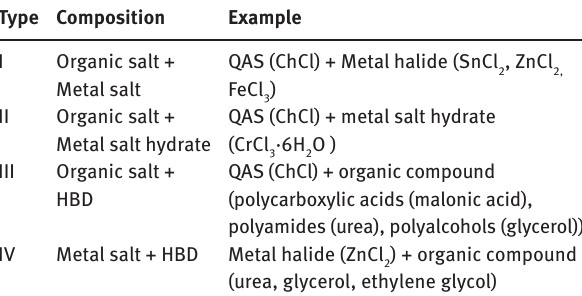
Table 1: Types of DESs